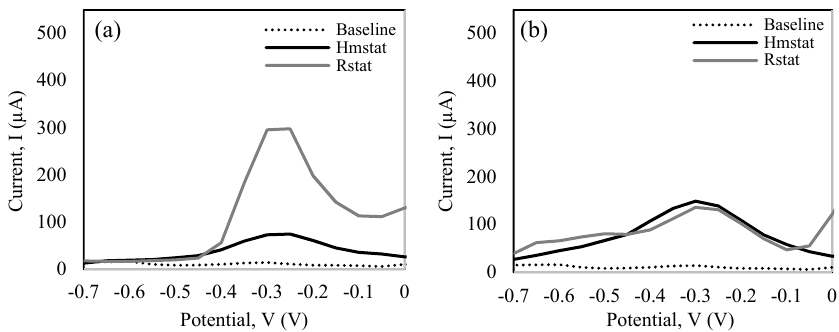
Figure 7. Comparison detection peak between HMstat and Rodeostat (Rstat) for ( a ) Cd 2 + and ( b ) Pb 2 + . Using the same experimental condition as in Figure 6.